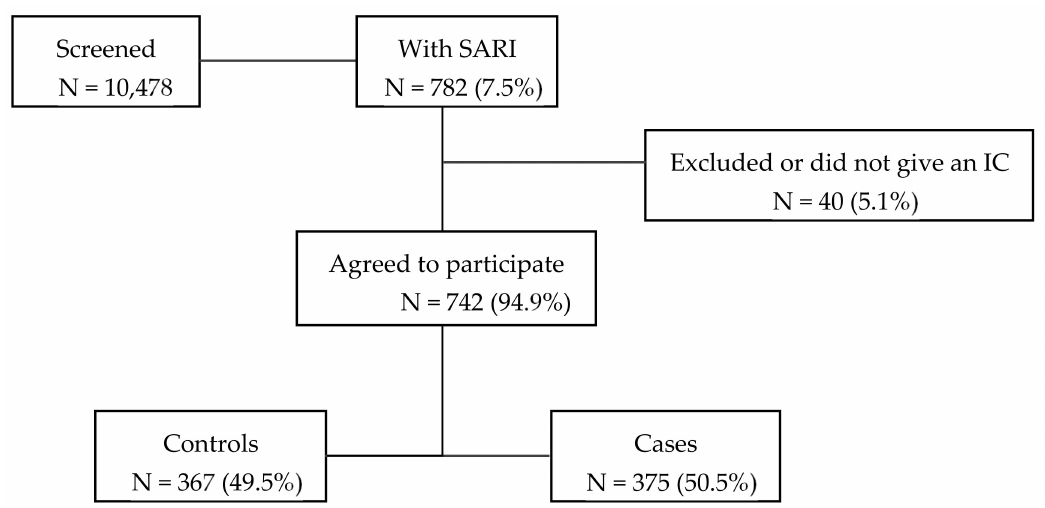
Figure 1. Flowchart of the recruitment of